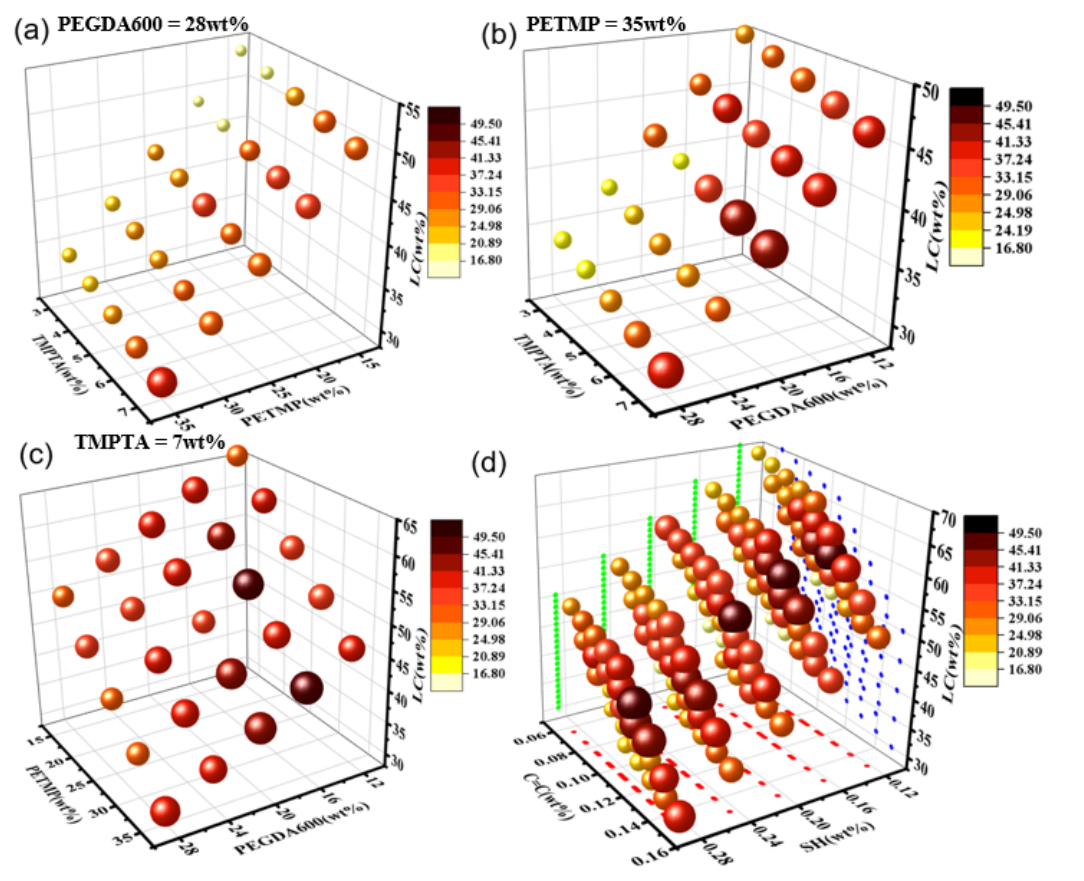
Figure 4. ( a ) Four-dimensional diagram with PETMP, TMPTA, and LC content as the coordinate axis; ( b ) Four-dimensional diagram with PEGDA600, TMPTA, and LC content as the coordinate axis; ( c ) Four-dimensional diagram with PEGDA600, PETMP and LC content as the coordinate axis; ( d ) Four-dimensional diagram with the functionality of thiol monomers, crosslinker functionality and LC content as coordinates.